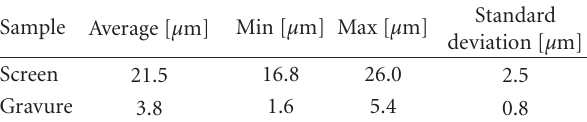
Table 5: Thickness measurement statistics for the printed